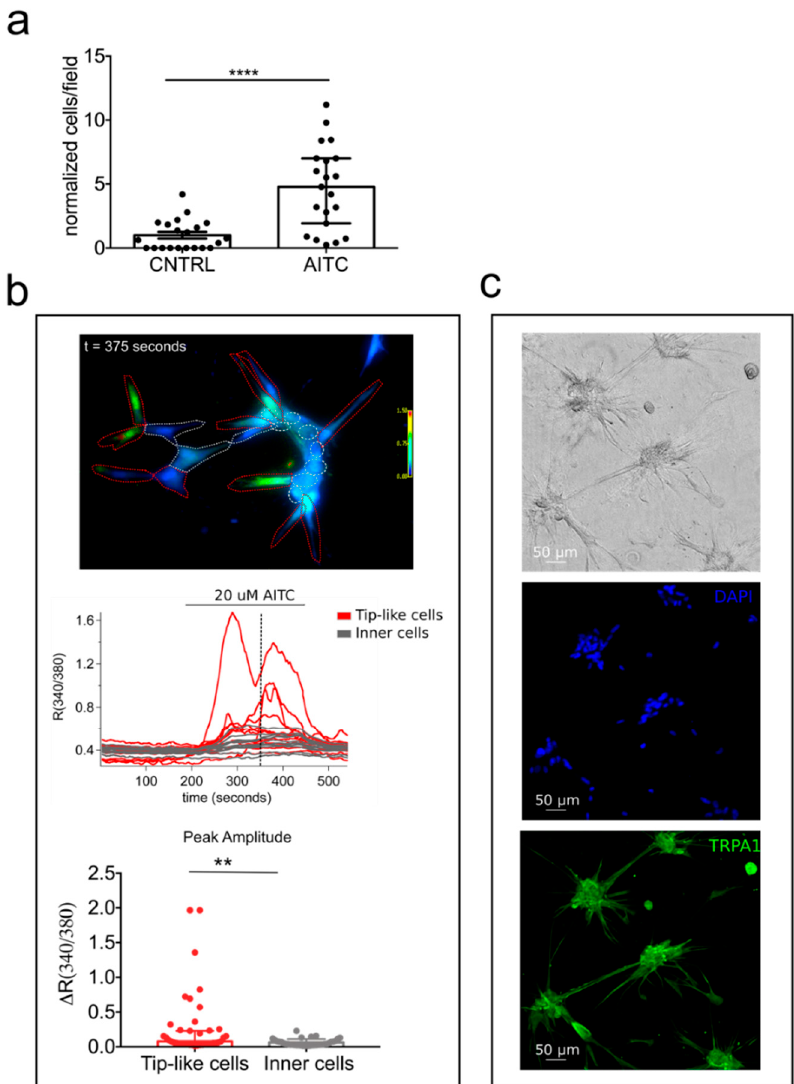
Figure 8. TRPA1 is implicated in PTEC chemotaxis and function in tip-like cells. ( a ) hTERT PTEC were plated in the upper chamber of 8 µm-pore culture inserts in the presence or absence of 20 μ M AITC. AITC significantly increased hTERT PTEC chemoattraction through the membrane, quantified 24 h after plating. Each dot indicates cell number in a single field normalized to hTERT PTEC cell count; results are presented as normalized values against CNTRL hTERT PTEC (median ± 95% CI of normalized cells in the field cells from 4 independent experiments). Statistical significance ****: p -value < 0.0001 (Mann-Whitney test). ( b ) TRPA1-mediated Ca 2+ responses in migrating (tip-like) versus non-migrating cells (inner cells). Upper panel: representative field showing 20 μ M AITC-induced Ca 2+ responses in hTERT PTEC plated on Matrigel/collagen substrate. Representative image in pseudocolor showing regions of interest (ROIs) representing “tip-like” cells (red ROIs) or “inner” cells (gray ROIs) at the peak of AITC-induced response ( t = 375 seconds as indicated in panel c, dotted line). Middle panel: each trace represents the ratio (340/380 nm) of a single cell in the field from one representative experiment ( n = 5 experiments). Lower panel: bar plot showing peak amplitude of AITC-mediated Ca 2+ responses (median ± 95% CI of different cells in the field from 5 independent experiments). Statistical significance and **: p -value < 0.01 (Mann-Whitney test). ( c ) Representative images of hTERT PTEC plated on Matrigel / collagen substrate showing phase contrast (upper panel), DAPI (middle panel) and TRPA1 expression in green (lower